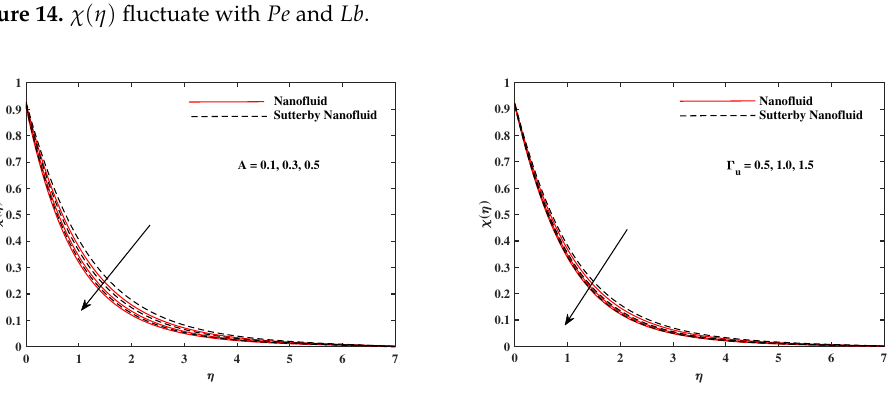
Figure 15. χ ( η ) fluctuate with A and Γ u